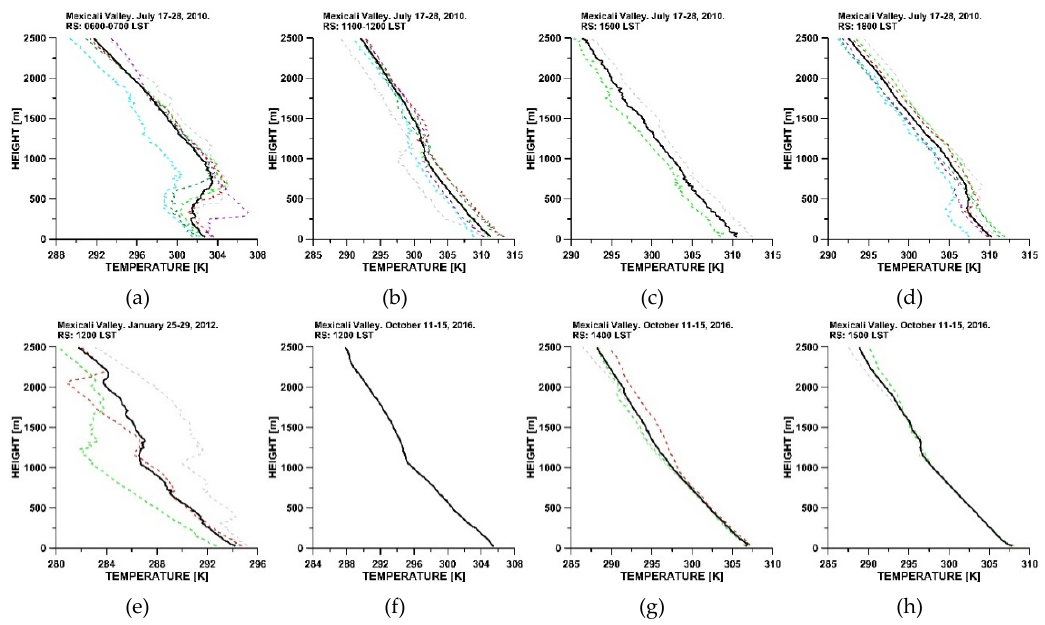
Figure 6. Temperature profiles obtained from the RS during daylight conditions. ( a ) 06:00 LST, ( b ) 12:00 LST, ( c ) 15:00 LST, and ( d ) 18:00 LST from the summer RS campaign; ( e ) 12:00 LST from the winter campaign; and ( f ) 12:00 LST, ( g ) 14:00 LST, and ( h ) 15:00 LST from the autumn campaign. The solid line represents the average profile. We carried out only one RS at 12:00 LST during the autumn campaign. Table 4. Estimation of the Mexicali Valley convective mixing height from atmospheric soundings. Summer 2010 Mixing Height Estimations (m)